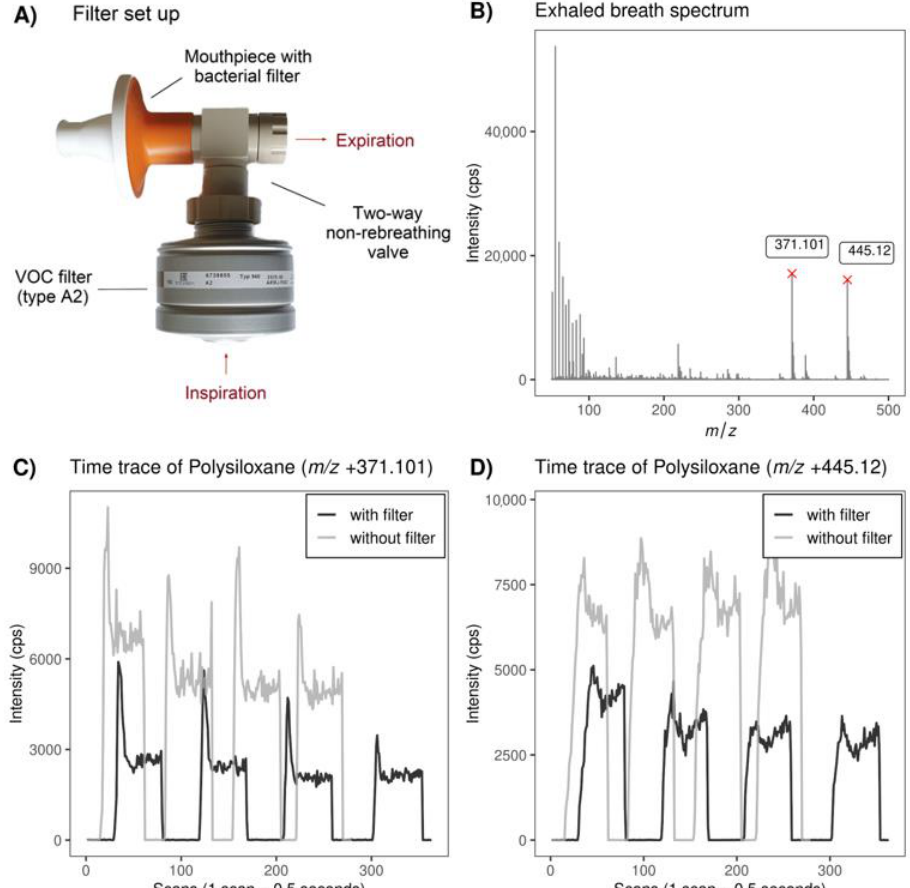
Figure 5. ( A ) Picture of the VOC filter connected to two-way non-rebreathing T-valve, which is custom-made from PEEK and has an attached mouthpiece with a bacterial filter; ( B ) Average mass spectrum of exhaled breath without filter recorded from one subject; ( C ) Time traces of the plasticizer m/z 371.101 (decamethylcyclopentasiloxane) with and without filter from one subject; ( D ) Time traces of the plasticizer m/z 445.12 (dodecamethylcyclohexasiloxane) with and without filter from one subject.